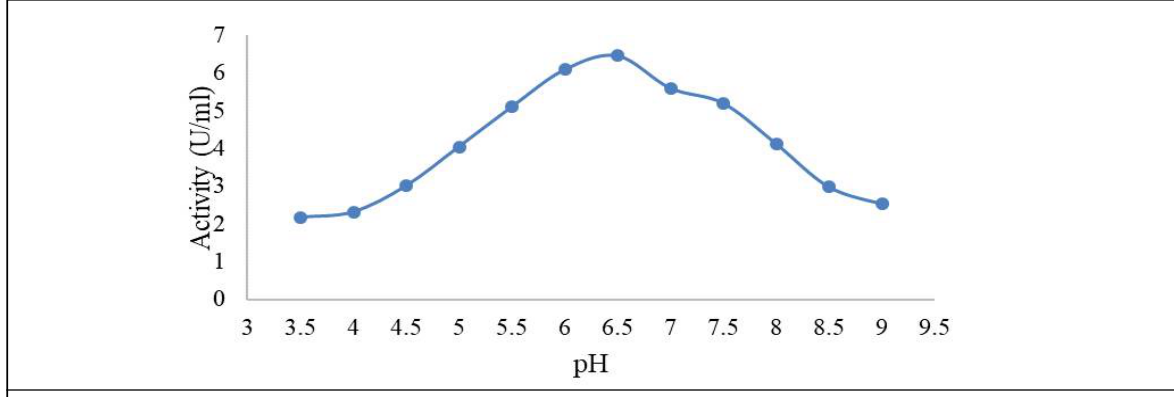
Figure 1: Effect of pH on peroxidase activity (fraction A)